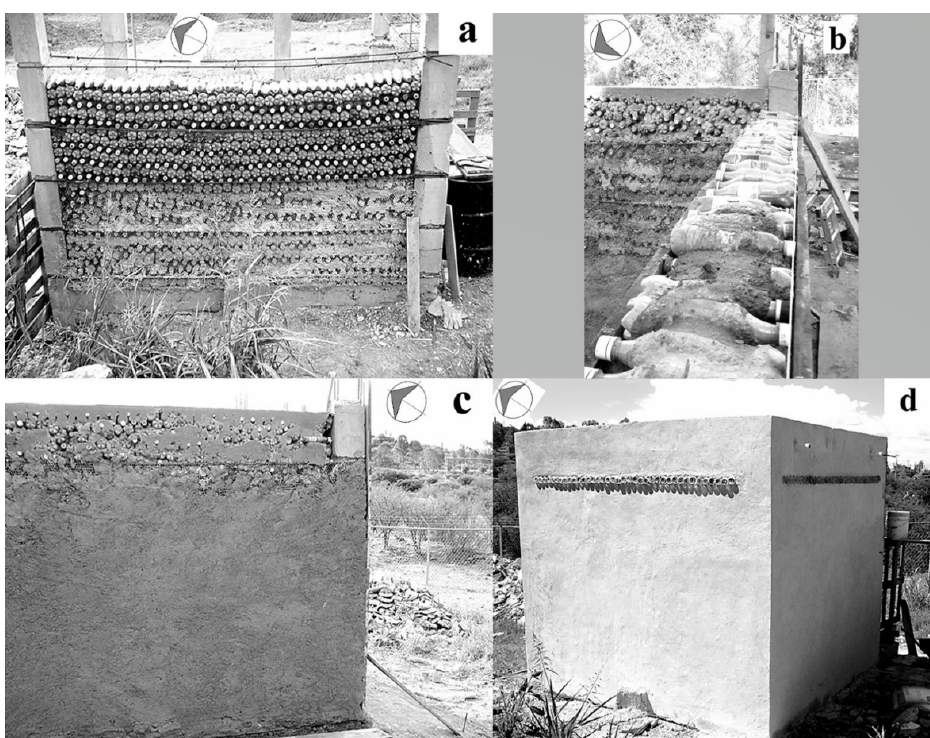
Figure 5. ( a ) Backside view of the PET bottle prototype showing them piled up and the horizontal rebar for reinforcement with the steel net; ( b ) bottle rows alternating top and bottom with galva- nized mesh and concrete; ( c ) plaster covering the wall; ( d ) finished lateral structure with a single row of skylights of waste glass bottles on three sides.